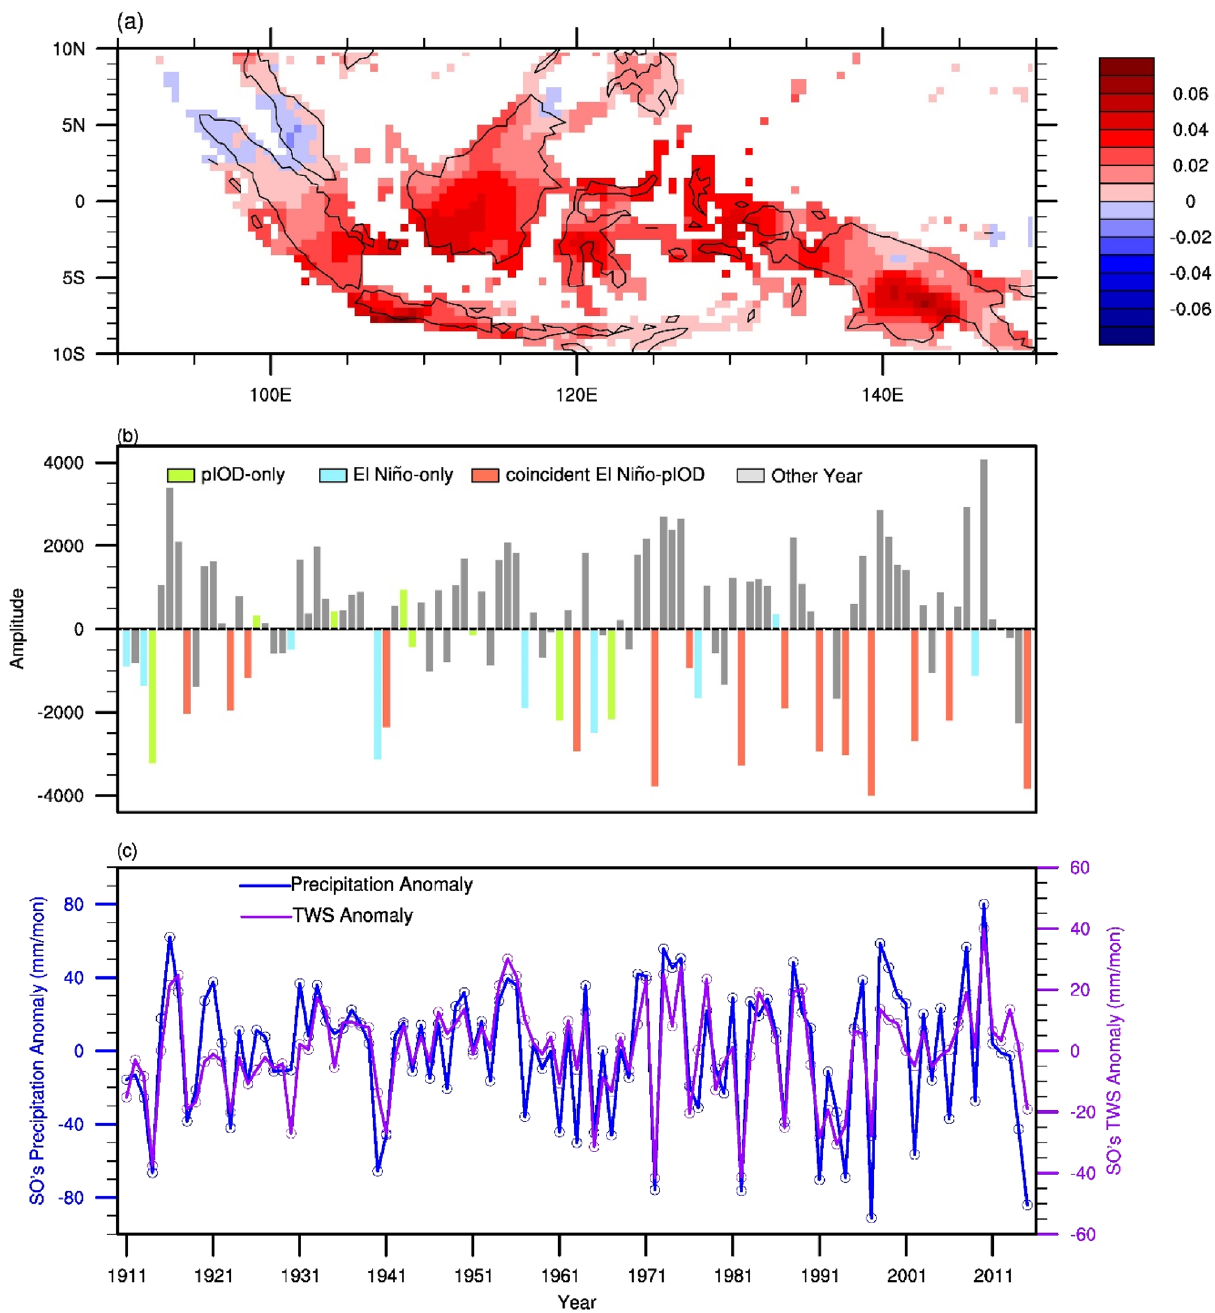
Figure 3. ( a ) First EOF mode of observed MC SO precipitation for the period 1911–2015. This mode explains approximately 34.2% of the variance. ( b ) First principal component (bar) during SO. The bars are rendered in green, blue, red, and gray for the pIOD-only, El Niño-only, coincident El Niño-pIOD, and other years, respectively. ( c ) The precipitation anomalies (blue line) and TWS anomalies (purple line) in SO. The anomalies are computed by removing annual cycle. The figures were plotted by NCAR Command Language (NCL) version 6.5.0 (https:// www. ncl. ucar. suppression effect on MC precipitation from June to November than El Niño-only or pIDO-only events. A lagged response in TWS, in turn, leads to drier ground cover and increases the risk of severe fires in September–October. In other words, it is the significant decrease of precipitation in coincident El Niño-pIOD events and the lagged response of total water storage, the severe fires happened in SO (Fig. S1). We also discovered that the occurrence frequency of the coincident El Niño-pIOD events has greatly increased since the mid-1960s in the observations (Fig. 3b) and CMIP5 historical simulations (Fig. 4b).